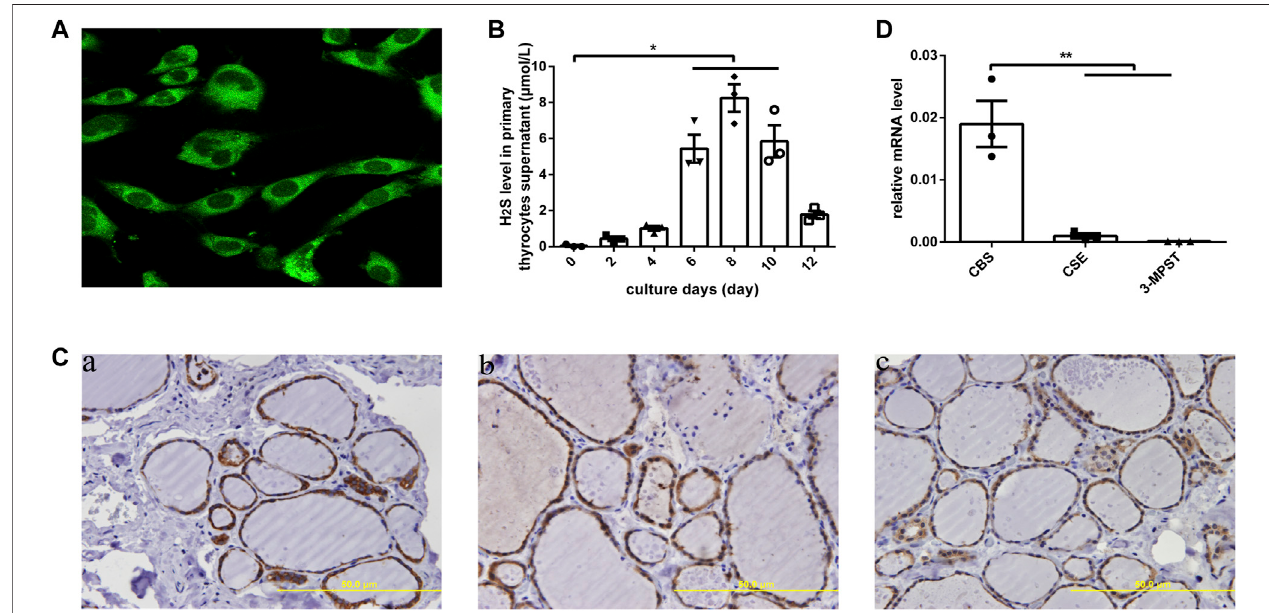
FIGURE 1 | H 2 S generation and related enzymes in human thyroid. (A) H 2 S generation in human primary thyrocytes was measured by an in situ fl uorescent H 2 S probe. (B) H 2 S levels in supernatants were detected by H 2 S-selective sensor in human primary thyrocytes with different culture days. (C) The enzymes that generated H 2 Sweredetectedbyimmunohistochemistrystaininginhumanthyroidtissues.Allofthemwerelocatedinthecytoplasmofthyrocytes.CBS(a),CSE(b),3-MPST(c). (D) The enzymes that generated H 2 S in human primary thyrocytes were detected by real-time PCR. The level of CBS mRNA expression is the highest. * p < .05, ** p < .01. CBS,cystathionine β -synthase;CSE,cystathionine γ -lyase;3-MPST,3-mercaptosulfurtransferase; H 2 S,hydrogen sul fi de. Dataareexpressedasthemean±SEM, and all experiments were performed independently three times.